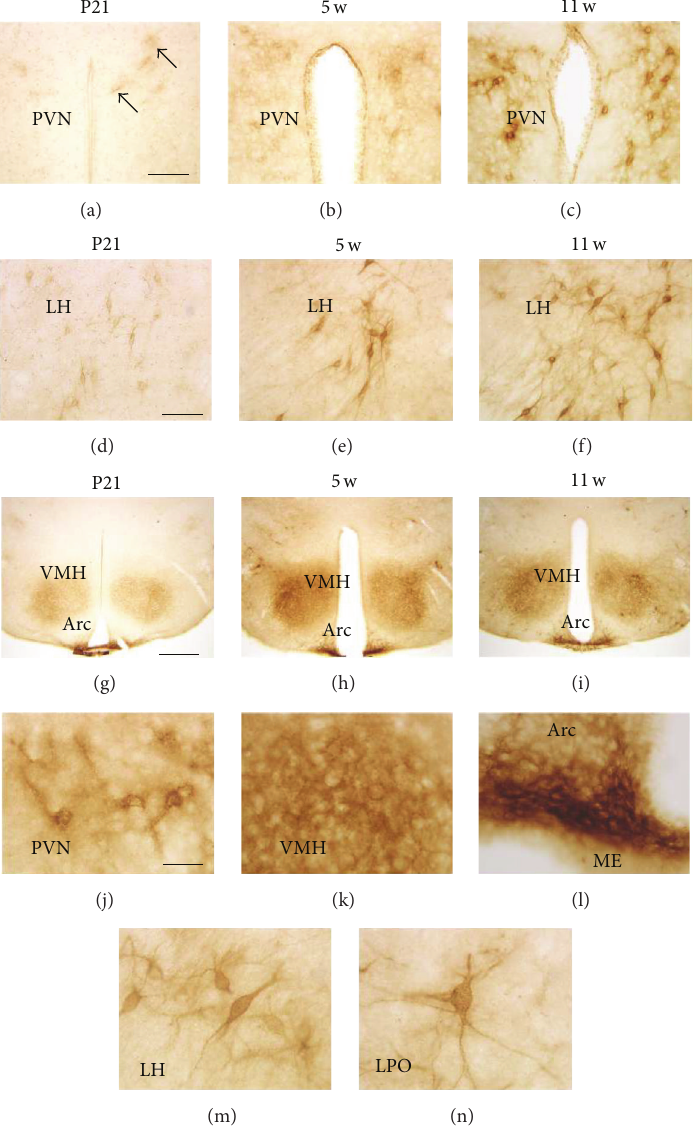
Figure 4: WFA-stained ECM in the developing hypothalamus. (a–i) WFA-labeled images in the PVN (a–c), LH (d–f), and VMH/Arc (g–i) at P21 (a, d, g), 5 w (b, e, h), and 11w (c, f, i). Ambiguous PNN-like staining (arrows) was observed in the PVN at P21, which became gradually clear over 5w to 11w. PNN-like staining was observed at P21 in the LH, which became clearer at 5w and 11w. In all stages shown, WFA reactivity in the VMH was diffuse, while that of the Arc was dense, particularly in its ventral portion neighboring the ME. (j–n) Higher magnification images of WFA labeling at 11w in the PVN (j), VMH (k), Arc (l), LH (M), and LPO (n). PNN structures in the PVN showed a diffuse manner, while those of the LH and LPO clearly surrounded cell bodies and dendrites. In the VMH and Arc, WFA reactivity did not surround dendrites. Arc: arcuate nucleus; LH: lateral hypothalamus; LPO: lateral preoptic area; ME: median eminence; PVN: paraventricular nucleus; VMH: ventromedial hypothalamic nucleus. Scale bars = 100 (a–f), 400 (g–i), and 40 (j–n) 𝜇 m.